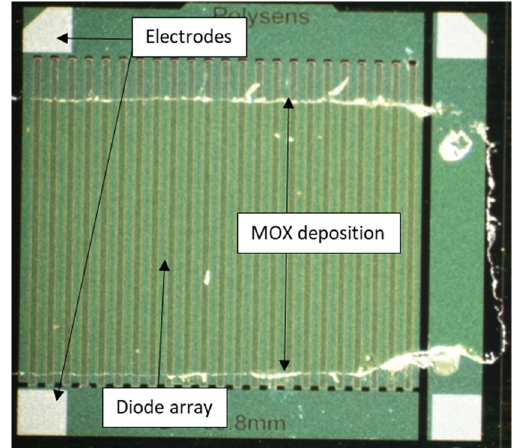
Figure 6. Single device of Zener diode array with MOx thin layer deposition.